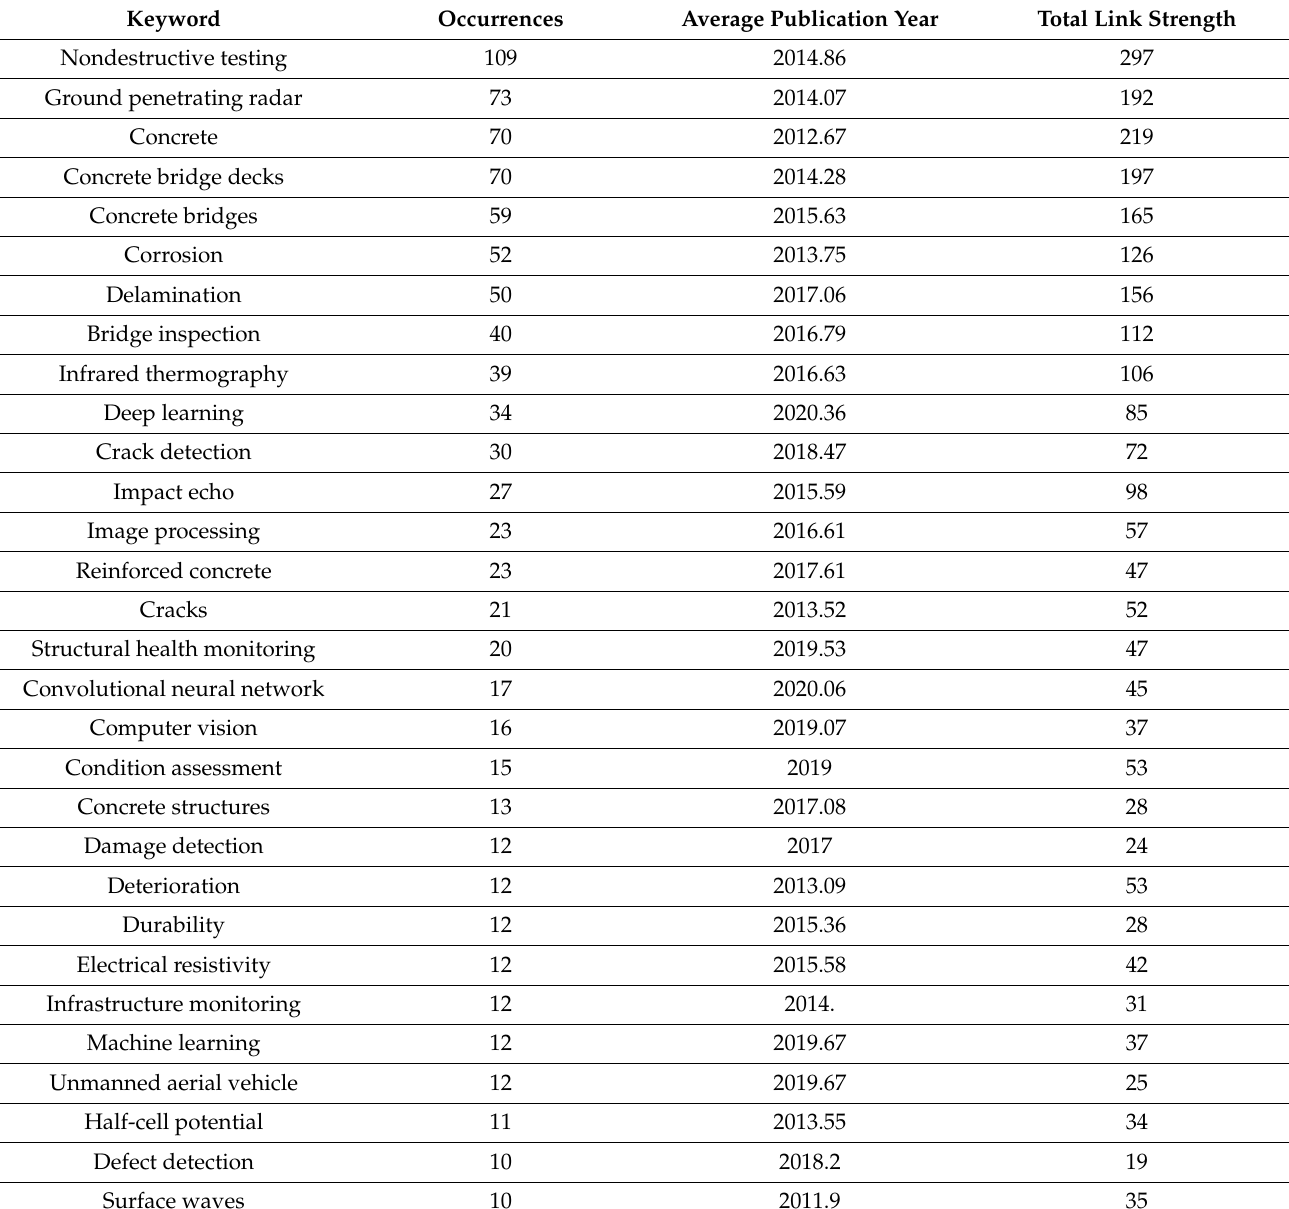
Table 5. Quantitative summary of the main keywords in the field of